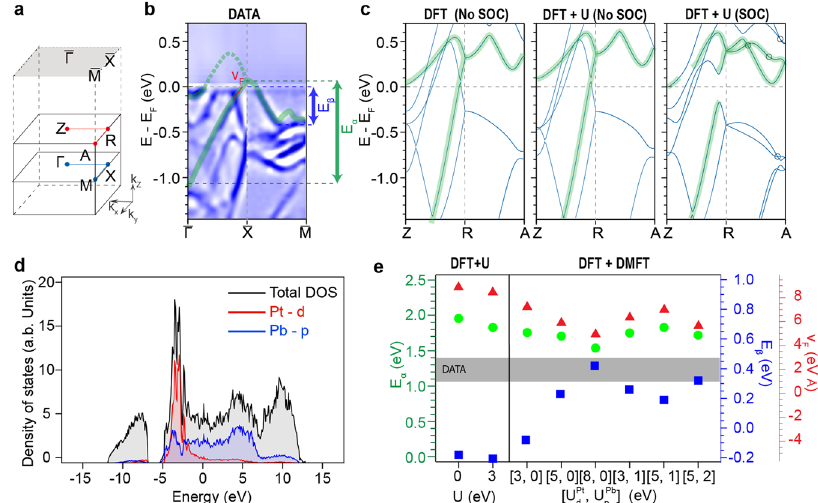
Fig. 4 First-principle calculations of the electronic structure. a BZ notations for the tetragonal unit cell and the projected surface BZ. b 2D curvature of the measured spectral image along Γ (cid:2) X (cid:2) M for comparison. c DFT, DFT + U ( U = 3 eV), and DFT + U with SOC calculations along the Z – R – A directions. Accidental crossings protected by the nonsymmorphic symmetry in the presence of SOC along R – A are circled. d Calculated partial density of states from DFT. e Extracted quantities as de fi ned in b for DFT + U as well as DFT + DMFT (see Supplementary Fig. 8 in Supplementary Materials) calculations shown compared to the value from measurement, indicated by the position of the gray bar for all three axes. E α is the bandwidth of the lower branch of the green highlighted band along Z – R ; v F is its Fermi velocity; E β is the portion of the green branch along R – A below E F